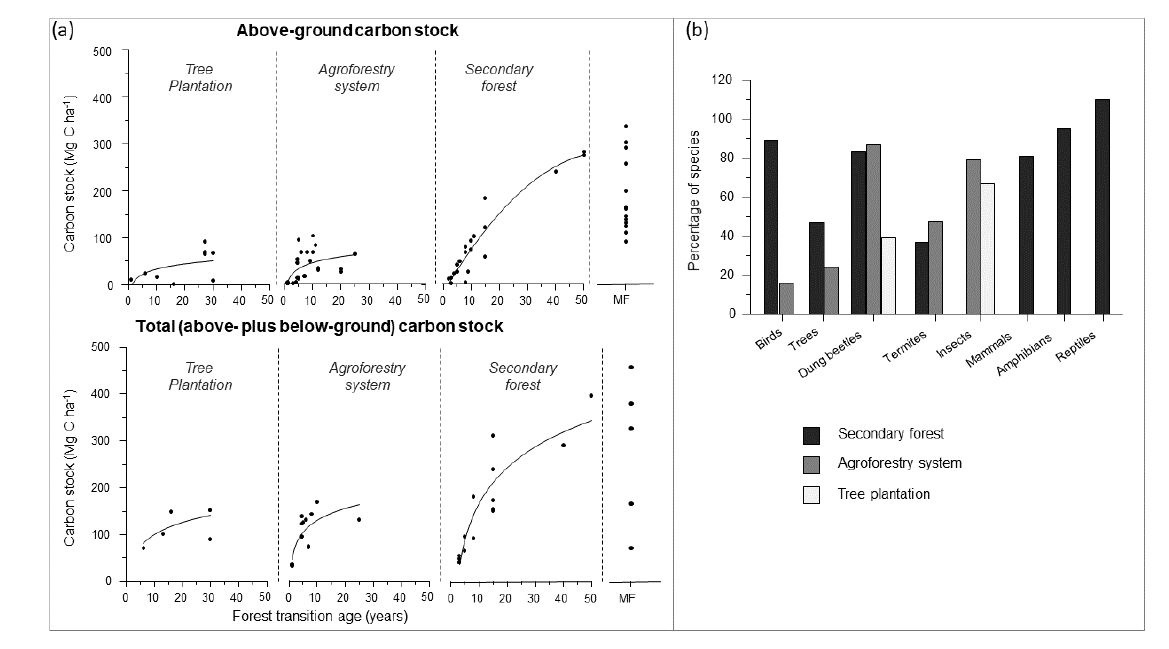
Fig. 2. (a) Carbon stocks and (b) biodiversity values in secondary forests and in two human-assisted post-deforestation regrowth forests (tree plantations and agroforestry system) in the Amazon region. In Fig. 2b, percent of species represents a percentage compared to a mature forest baseline. MF: mature forest. Data used for these figures are in